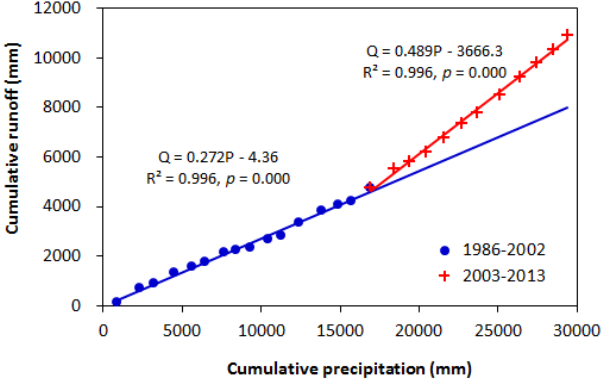
Figure 12. Trend of annual water balance and potential evapotran- spiration (PET) for the Qinhuai River basin from 1986–2013. ET was estimated as the difference between precipitation ( P ) and mea- sured stream flow ( Q